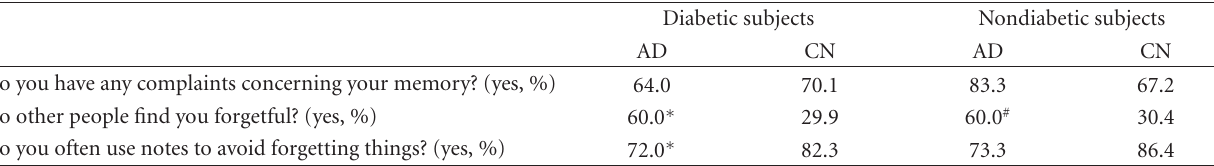
Table 2: Subjective complaints of memory deficits.